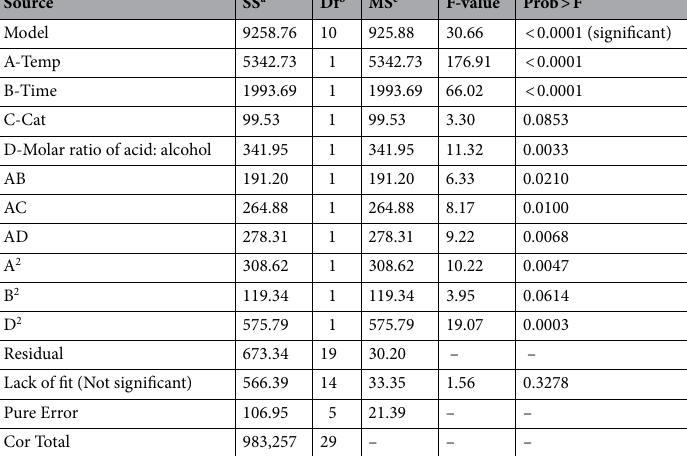
Table 1. ANOVA table of the quadratic response surface model. a Stand for sum of square. b Degree of freedom. c Mean of